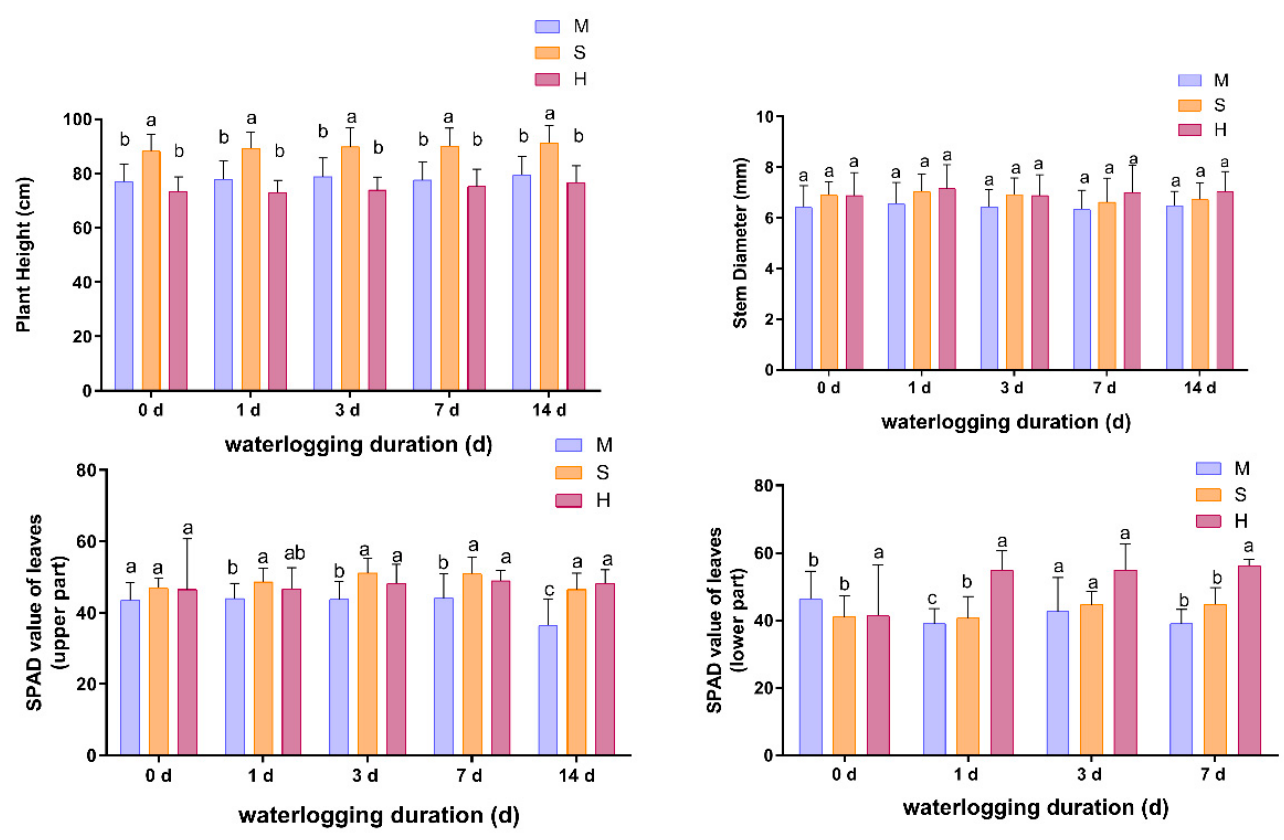
Figure 1. The changes of plant height, the stem diameter and leaf SPAD value of three peach rootstocks seedlings with the prolongation of waterlogging exposure. Abbreviations: M: Prunus persica, ‘Maotao’; S: Prunus davidiana, ‘Shantao’; H: ‘Hossu’. The data are the means ± SDs. Within columns, means with a different letter indicate significant differences ( p < 0.05) using Duncan’s test, bars on the columns represent the standard error of the mean (n = 6). The defoliation of S was too severe to provide enough samples for SPAD value measurements of lower part leaves at the 14th day of WT, therefore the leaf SPAD values on the 14th day of waterlogging are not shown in Figure 1. As shown in Table 1, the pre-waterlogged leaf stomatal density of S was much lower than that of M and H. The stomatal density of M and S increased modestly during the early stage of WT (1–3 d) but decreased quickly with the prolonged waterlogging exposure, while that of H showed an opposite tendency in that it decreased at first and then increased. Until the end of the waterlogging treatment (WT-14 d), the leaf stomatal density of H was even larger than that of the non-stressed condition, and M displayed a higher stomatal closure ratio (%) than the other two rootstocks. After 14 days of WT, the leaf stomatal morphology of three peach rootstocks was compared in Figure